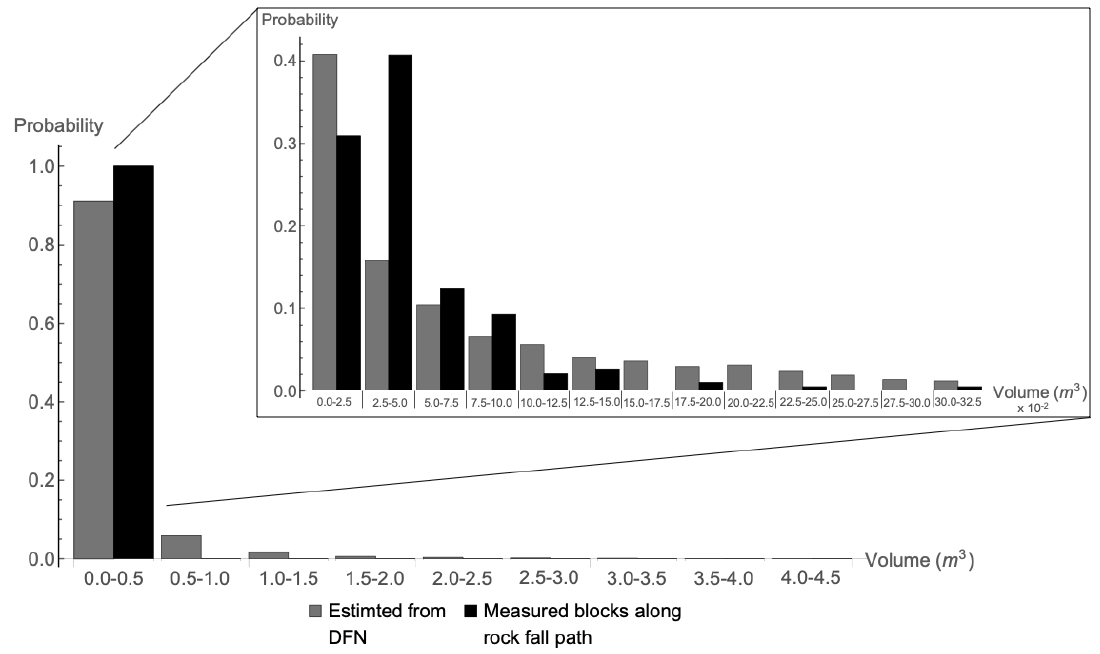
Figure 12. Fragmented rockfall volume distribution as calculated by the persistent DFN method and field surveys for Site S042.